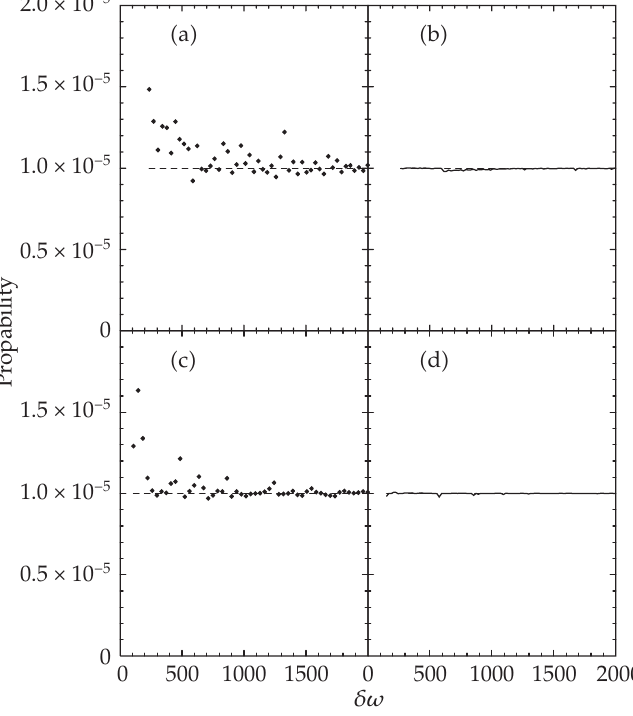
for protons with J/ ( 2 π ) ∼ 10 Hz ( for estimations in this paragraph we use the dimensional units ) with the distance between the neighboring spins a = 2nm, the value δω/J = 1000 gives the gradient of the magnetic field δω/ ( γa cos θ ) ∼ 2 × 10 5 T/m [ 6, 12 ] . From Figure 7.3, we can see that this is the minimum value of the gradient of the magnetic field for ≈ 155 when Ω = Ω 5 and L ≈ 740 when Ω = Ω 11 required to make L max max the error less than P 0 = 10 5 . At L > L max , at a given gradient of the mag- netic field, and at Ω ≈ Ω k , k = 5 or 11, the error will be always larger than P 0